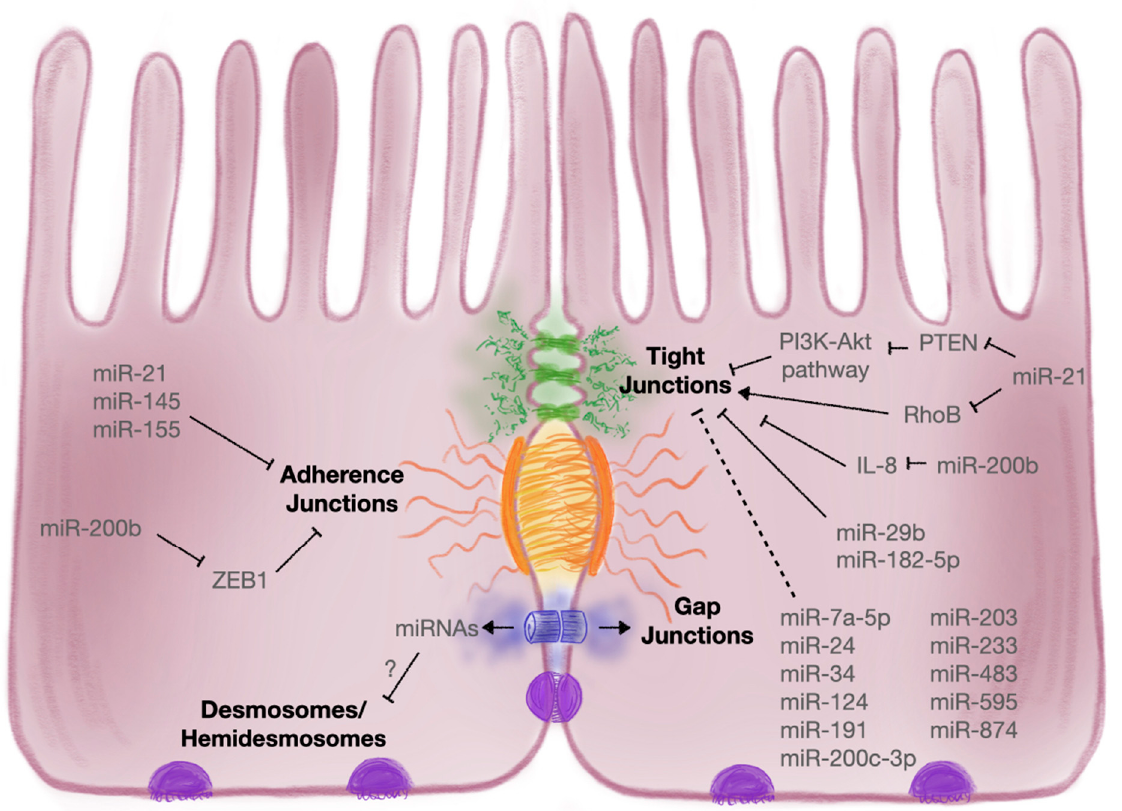
Figure 2. Overview of altered miRNAs during IBD shown to target intercellular junction proteins and thereby weakening the gut barrier. Dashed line: indirect target, solid line: direct target.